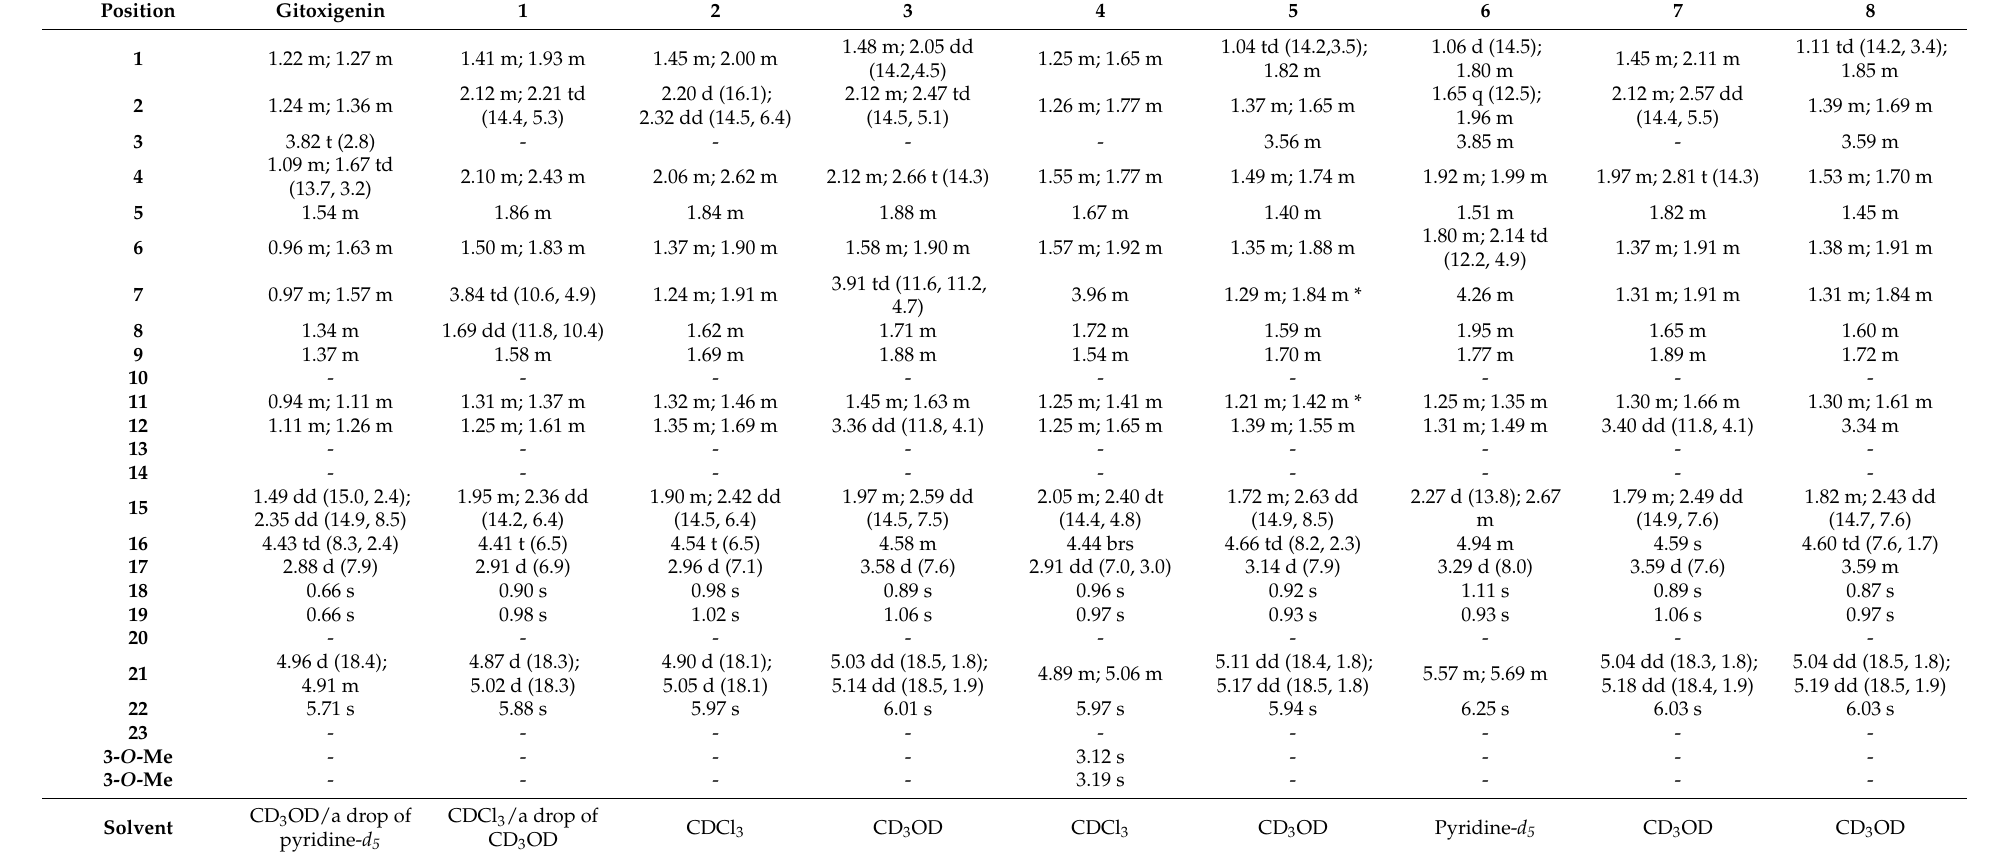
Table 1. 1 H NMR data of gitoxigenin and compounds 1–8 ( δ H (ppm), ( J ,